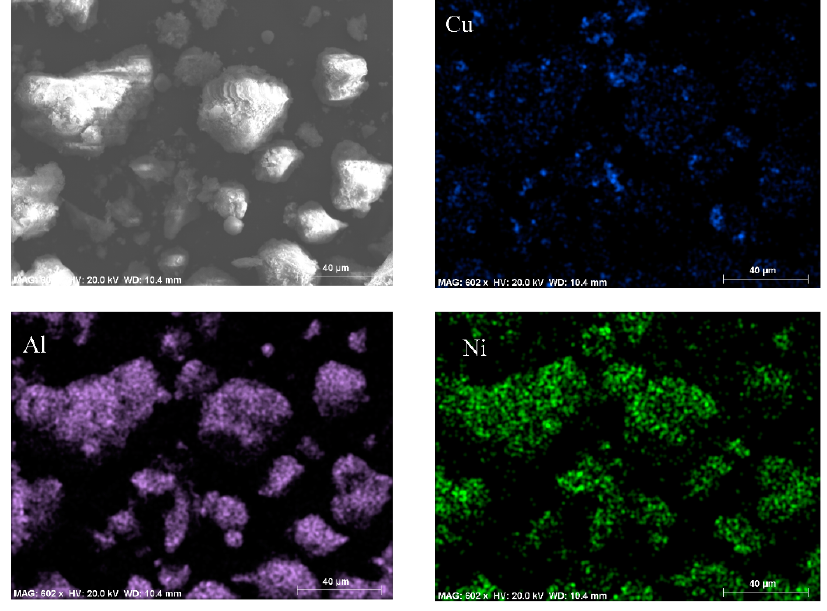
Figure 5. SEM and energy dispersive X ‐ ray (EDX) mapping of 18 wt. % Ni 0.5 ‐ Cu 0.5 / γ‐ Al 2 O 3 catalyst.